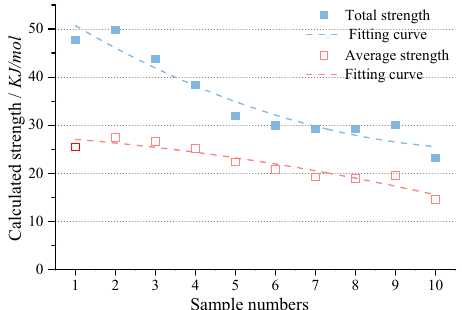
Figure 7. Total and average strength of HBs.